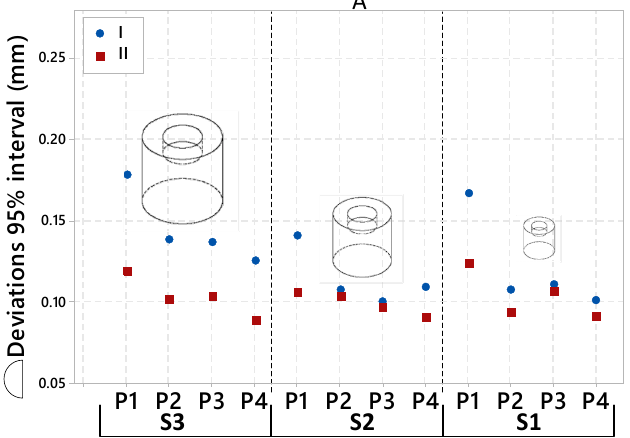
Figure 10. Nonparametric distribution function 95% interval of the 12 Shape A artifacts carried out as-built (blue) and after stress relief (red).